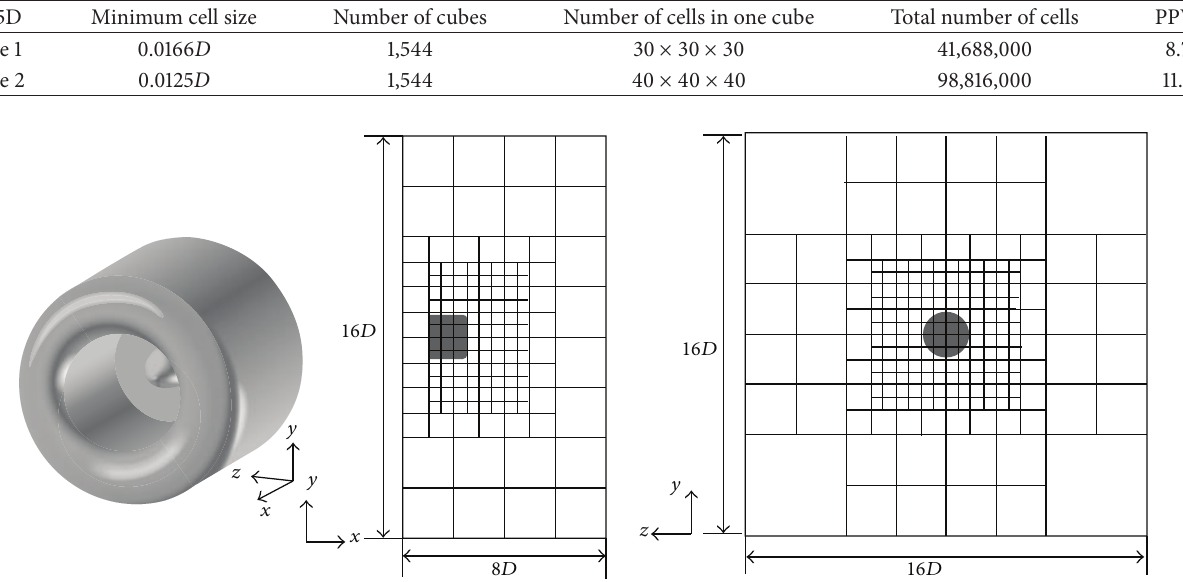
Figure 10: Computational domain for the JT15D nacelle.